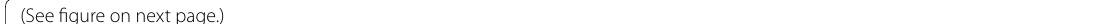
figure on next Fig. 2 a Age at symptom onset by decade of birth. b Age at diagnosis by decade of birth. c Delay in diagnosis by decade of birth. The horizontal line inside each box indicates the median, the lower and upper borders of each box indicate the first and third quartiles, and the lower and upper box whiskers indicate the minimum and maximum